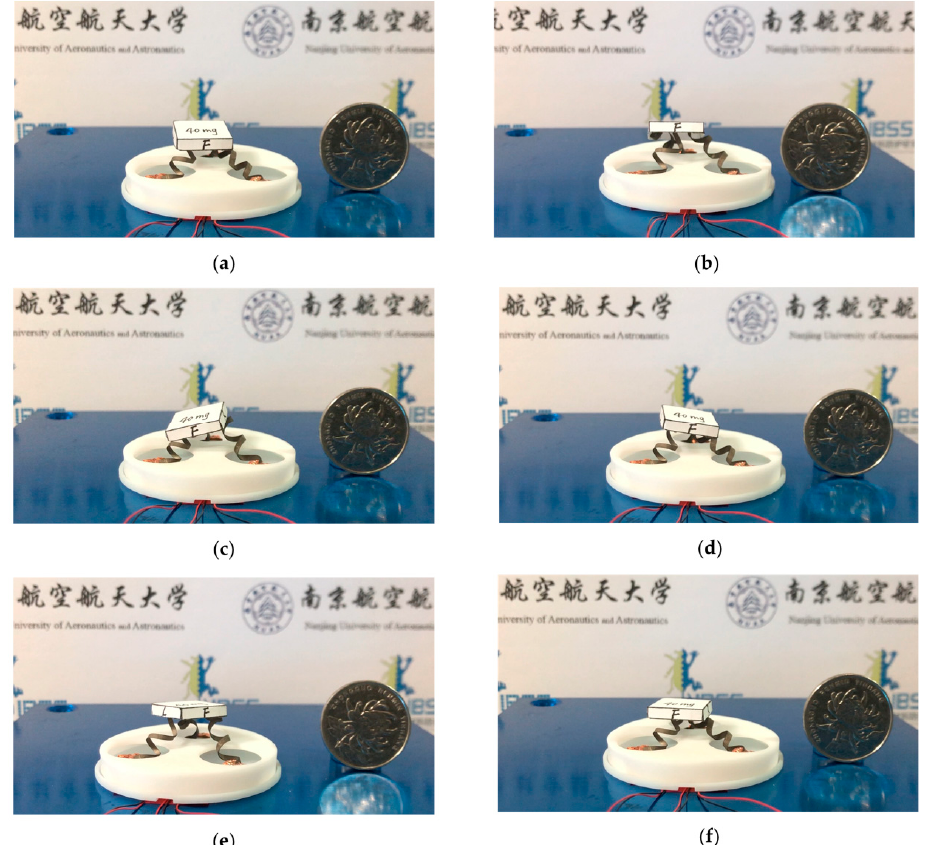
Figure 19. Coupling movement of the 3-DOF micro-parallel platform based on helical IPMC actuator: ( a , b ) pitch; ( c , d ) roll; ( e , f ) yaw.